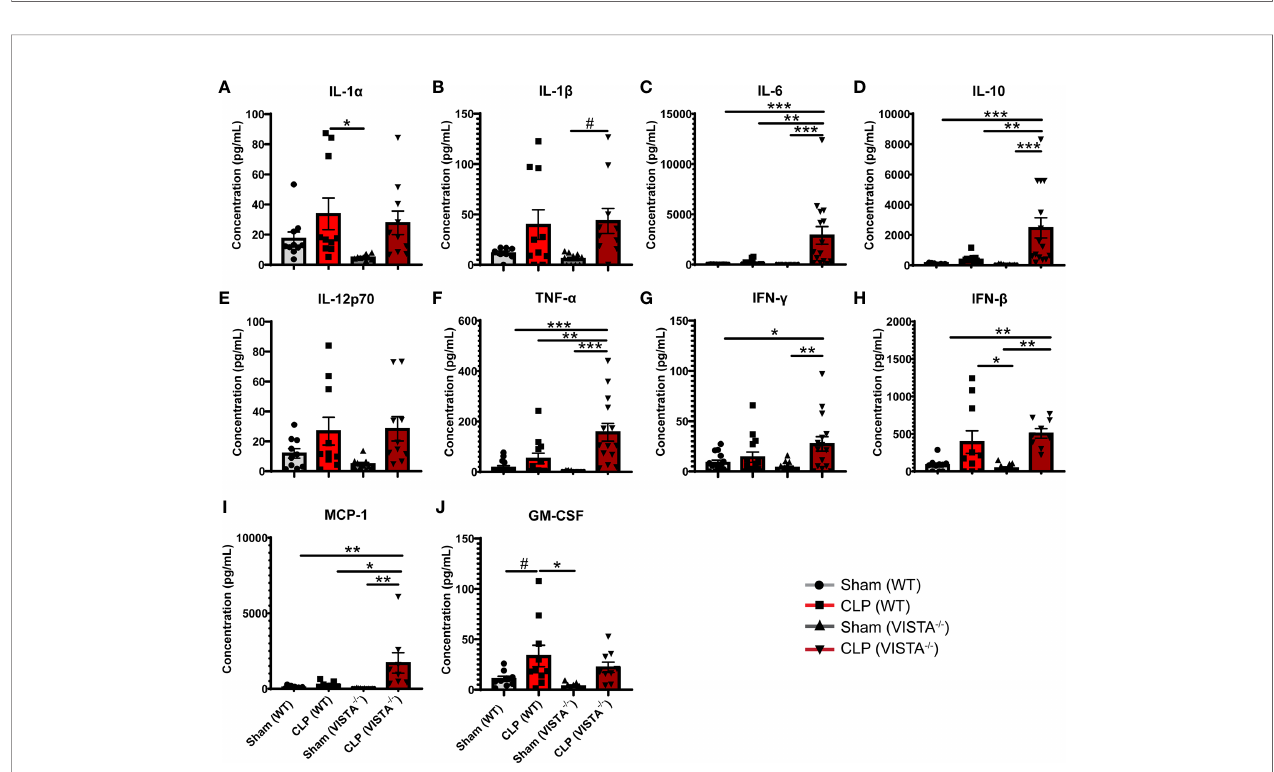
FIGURE 9 | VISTA -/- mice have signi fi cantly higher levels of several proin fl ammatory cytokines following septic challenge. (A – J) Plasma cytokine concentration of wild-type and VISTA -/- mice. Summary graphs show mean ± SEM [WT-sham: n = 10 , WT-CLP: n = 10 , VISTA -/- sham: n = 10 , VISTA -/- -CLP: n = 10 ]; signi fi cance # p = 0.05; *p < 0.05; **p < 0.01; ***p <